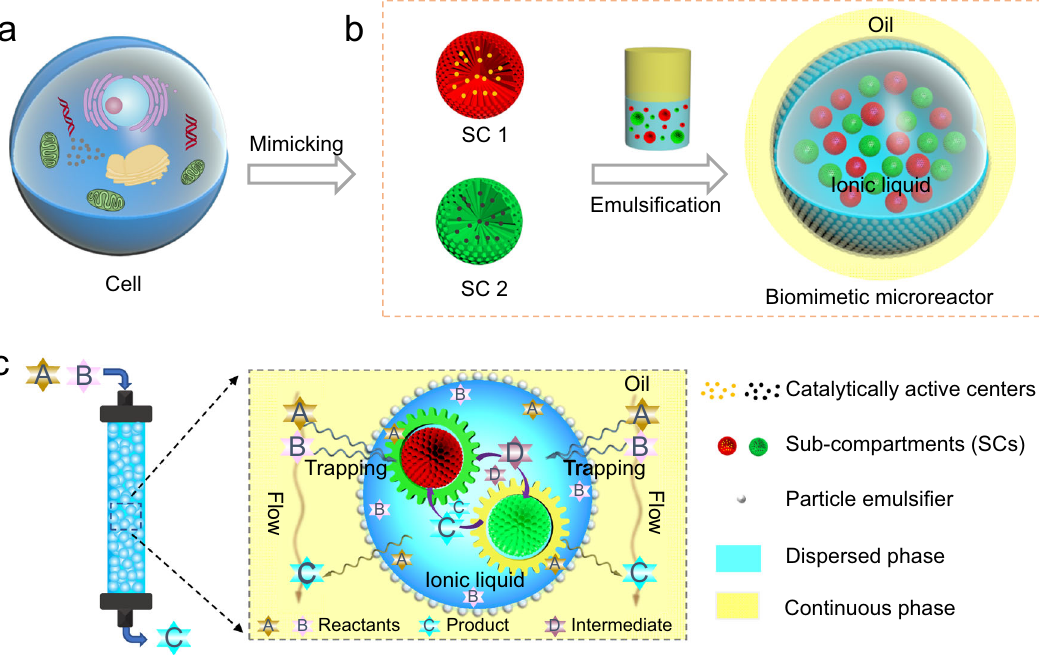
Fig. 1 Schematics for the construction of biomimetic microreactors for continuous fl ow cascade reactions. a Microstructures in a living cell. b Co- localization of two distinct catalytically active sub-compartments (SCs) within a single droplet of ionic liquid-in-oil Pickering emulsion generating a biomimetic microreactor. c Column reactor packed with the biomimetic microreactors for continuous fl ow cascade